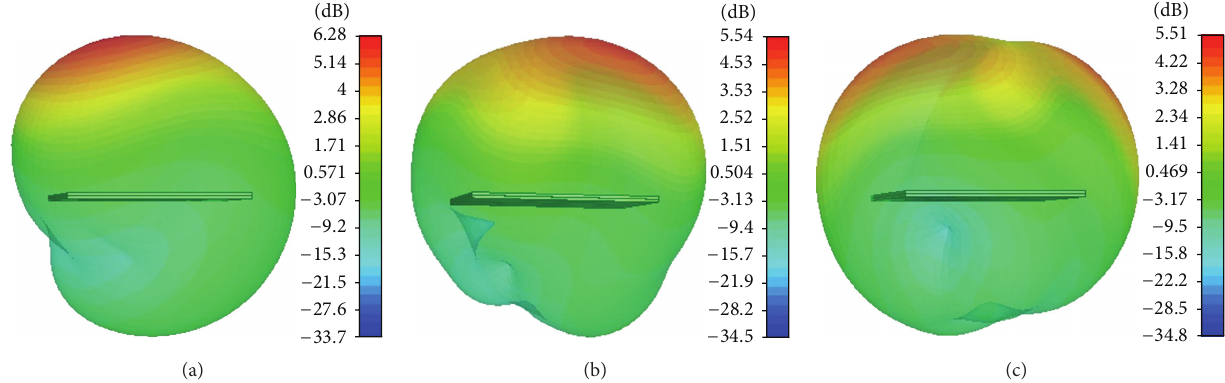
Figure 9: Simulated 3D radiation pattern of the proposed antenna at 2.39 GHz. (a) R-RFS B and C are ON. (b) R-RFS A, B, and C are ON. (c) R-RFS A and C are ON. The R-RFS that not was mentioned is in OFF state.